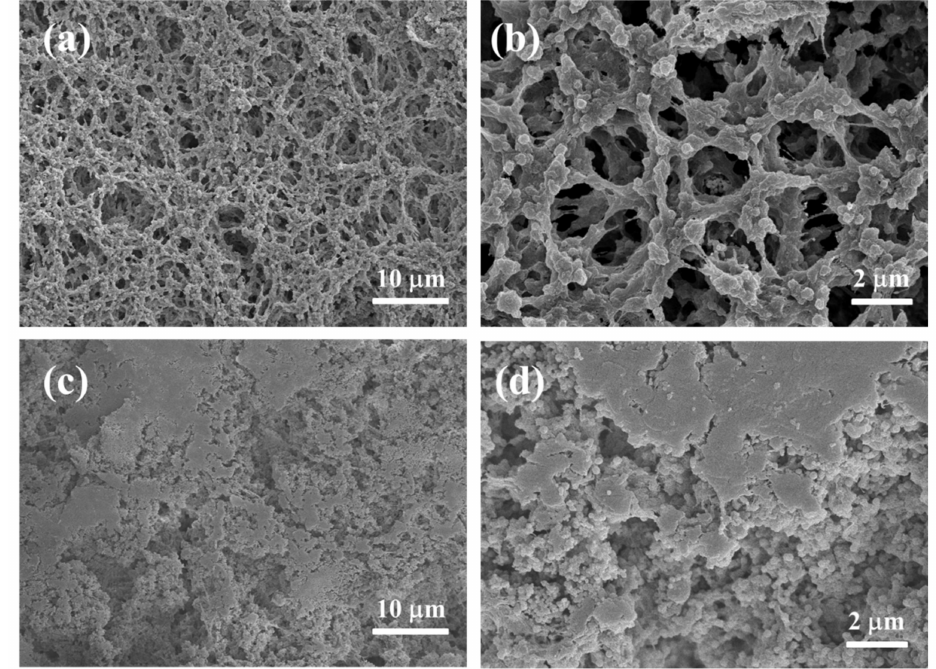
Figure 1. Top-view SEM images of I-Al/PVDF ( a , b ) and M-Al/PVDF ( c , d